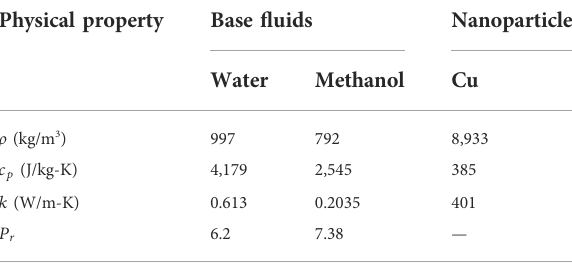
TABLE 1 Experimental values for the base fl uid and nanoparticles (Sajjan et al., 2022). Physical